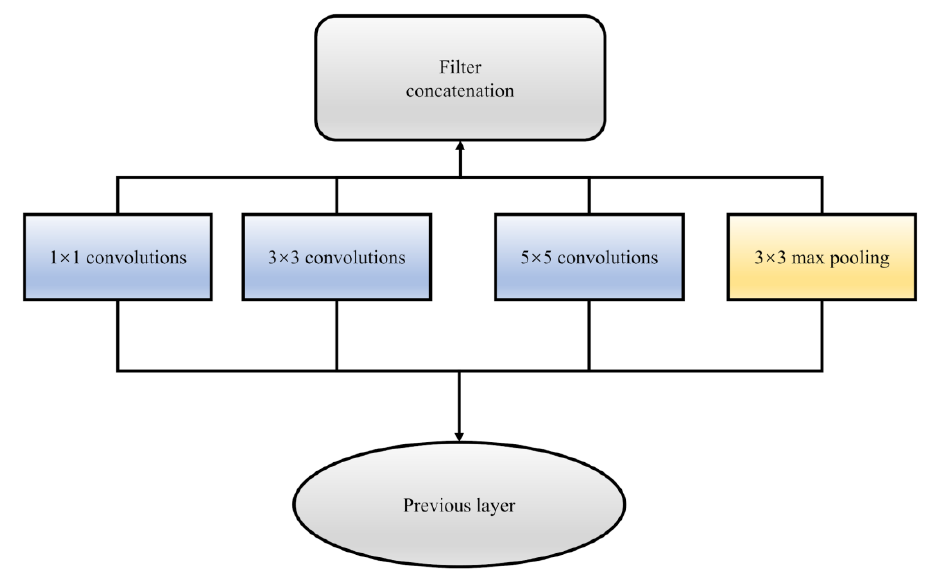
Figure 4. Traditional Inception-V1 structure.